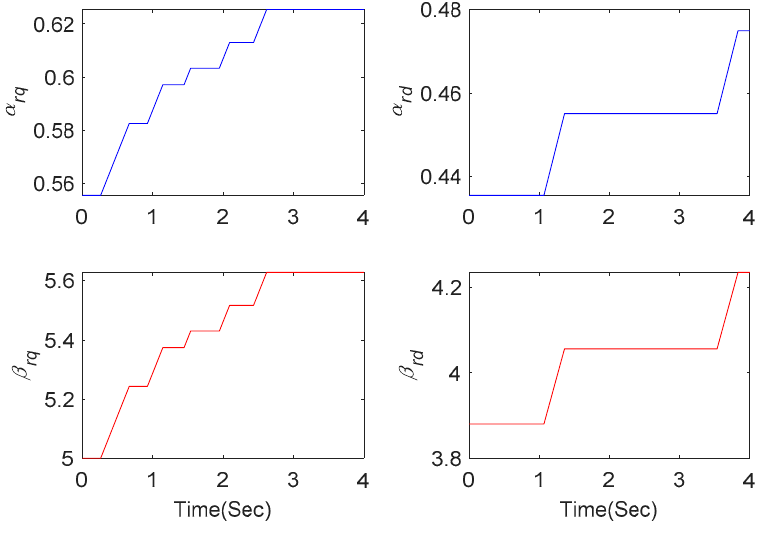
Figure 18. Adaptive control gains.